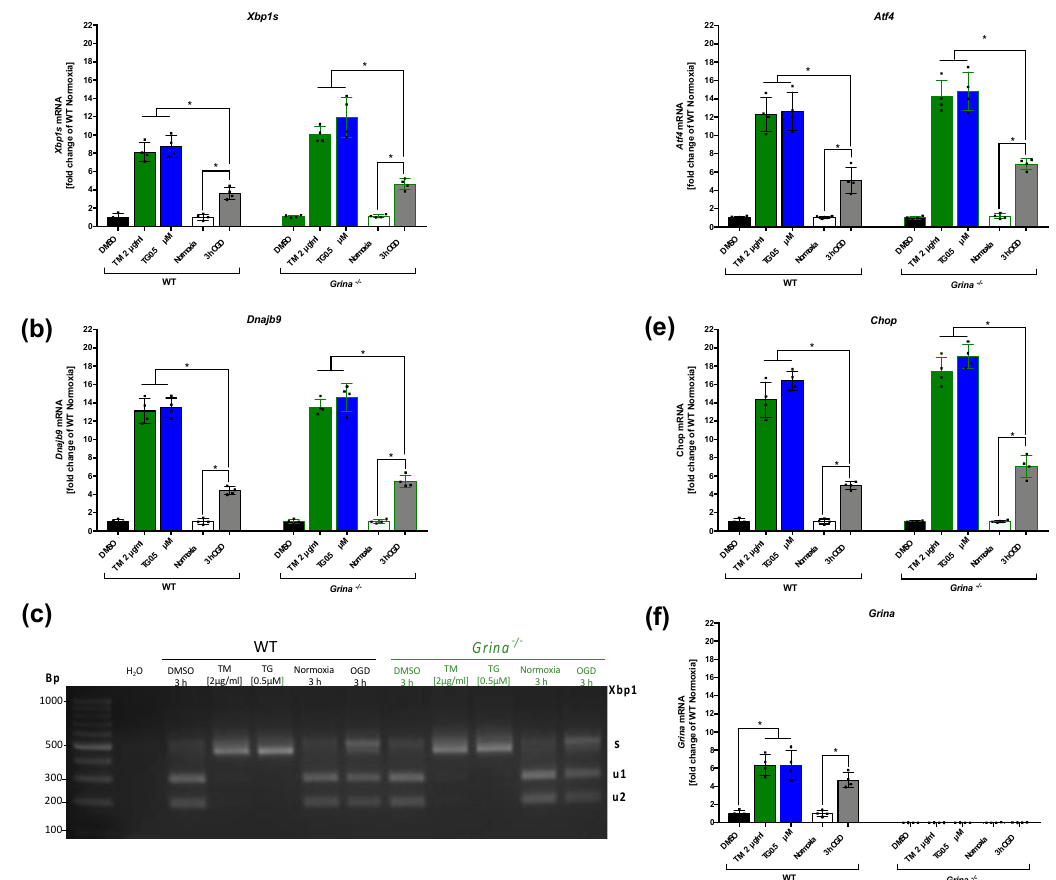
Figure 6. OGD activated the IRE1 α and PERK arm of the UPR with similar tendency as pharmacological treatment with Tunicamycin and ThapsigarginPrimary murine cortical cells were treated with TM (2 μ g/mL) or TG (0.5 μ M) for 4 h or subjected to OGD/normoxia for 3 h. For the activation of the IRE1 α branch of UPR after stroke, mRNA levels of Xbp1s ( a ) and Dnajb9 ( b ) were measured in GRINA-deficient and wildtype primary murine cortical cells using RT-qPCR. The expression of spliced Xbp1s mRNA was evaluated by an Xbp1 splicing detection assay ( c ). To evaluate PERK activation, mRNA levels of Atf4 ( d ) and Chop ( e ) were measured using RT-qPCR. The impact of TM, TG and 3 h of OGD on Grina mRNA levels in GRINA-deficient and wildtype primary murine cortical cells using RT-qPCR is shown ( f ). Bars represent means ± SD. n = 4 individual cell culture preperations from mice pups (P0–P2) of all genotypes and treatment groups. * p < 0.05 intergroup comparison.